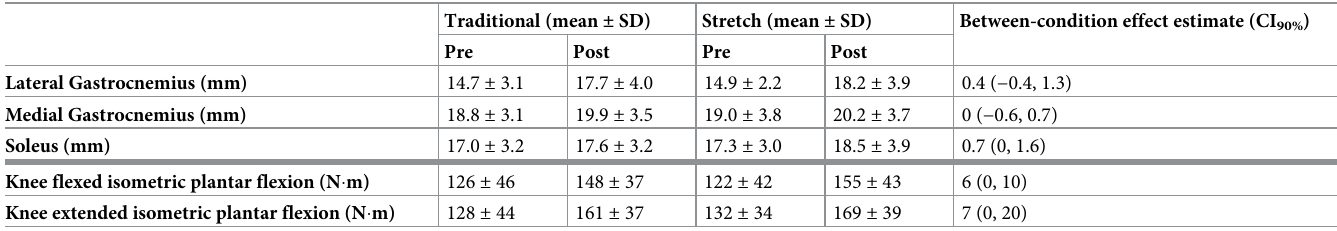
Table 1. Muscle size and strength